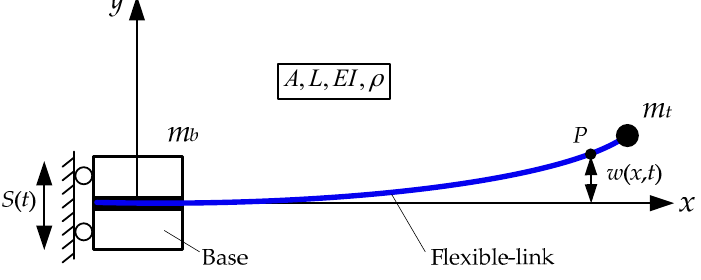
Figure 1. The translational flexible-link manipulator system.